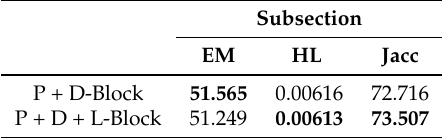
Table 4. Ablation study on the performance improvement of L-Block.